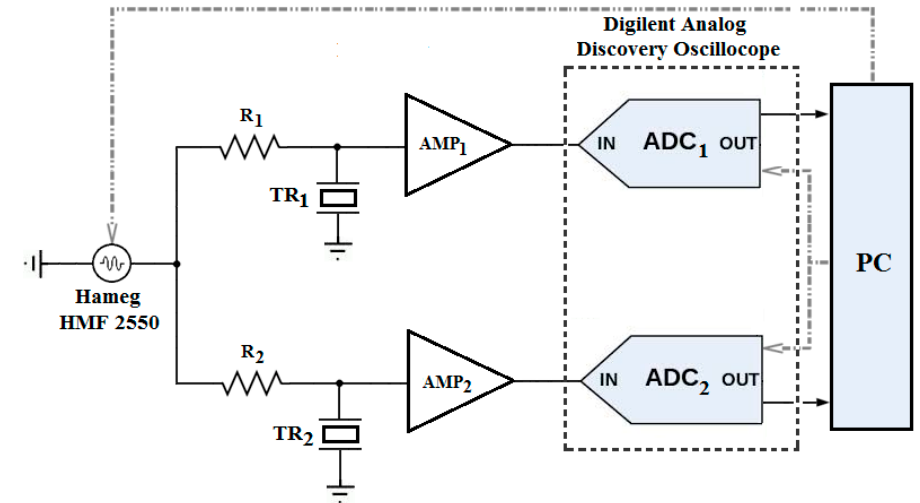
Figure 2. Diagram of the experimental system.